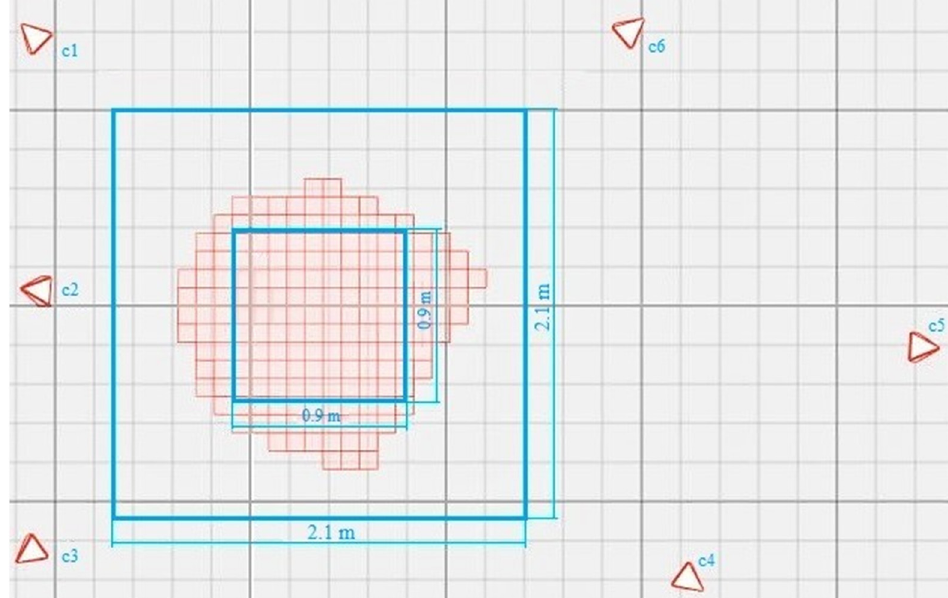
Figure 1. The OMC laboratory setup. The resulting capture areas with an overlap of six cameras (irregular squared red shape), and available workspace (external 2.1 × 2.1 m 2 blue square).